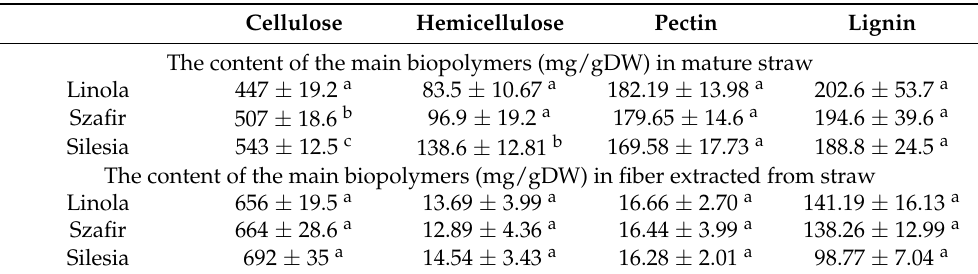
Table 3. The content of the main biopolymers in plant straw and fibers. All results are statistically significant ( p < 0.05). Different superscripts imply significant differences.